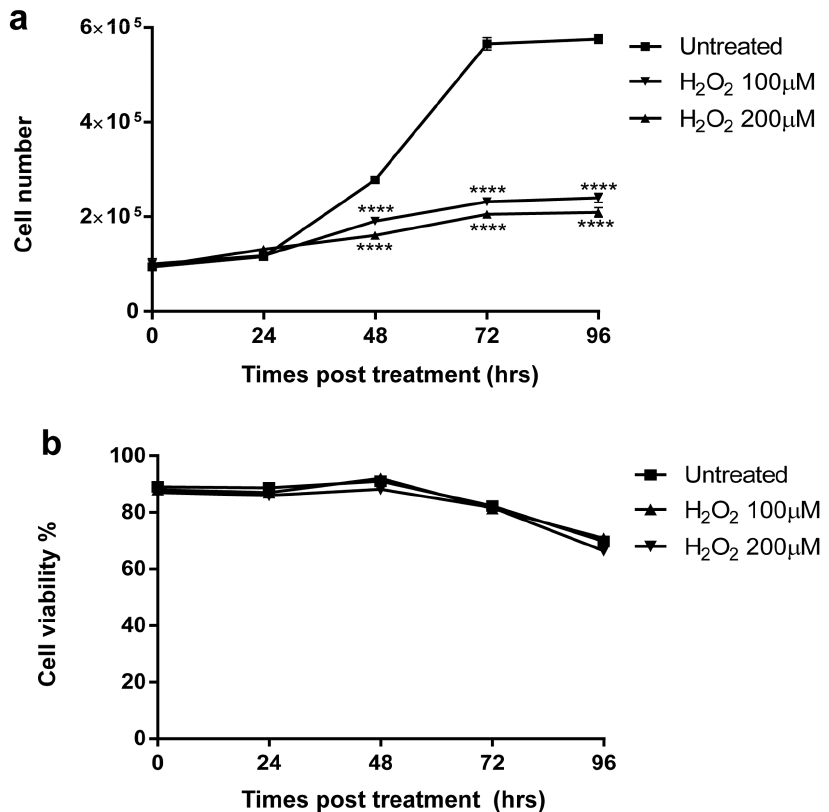
Figure 6. Cell growth and viability assay. MRC-5 cells were treated with H 2 O 2 at 100 and 200 m M. After treatment, cells were seeded (t 0 ) and harvested at different times. Total cells were counted using an electronic haemocytometer (a), and the percentage of viable cells was determined by propidium iodide exclusion by flow cytometry analysis (b). Every data point was assessed in triplicate and data are presented as means 6 SD. Comparisons between multiple groups were made by a two-way analysis of variance (ANOVA). ****p , 0.0001.